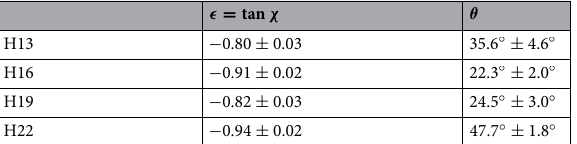
Table 2. Ellipticities ǫ and orientation angles θ retrieved by evaluating the polarimetry measurements for the harmonic radiation generated in the few-cycle setup at the position of the corresponding